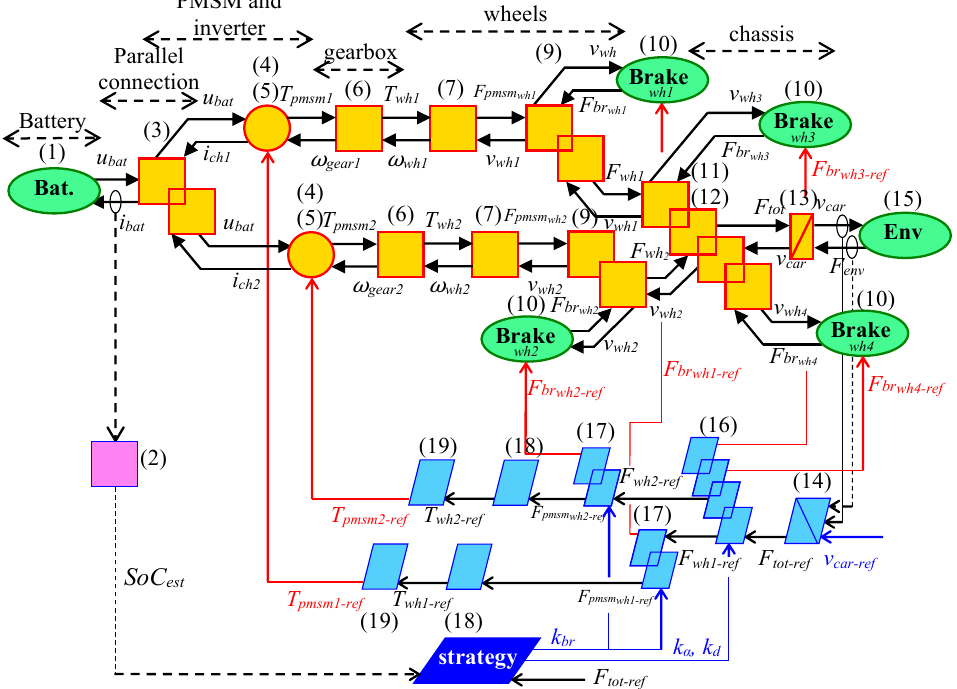
Figure 5. Maximum control structure for studied car model.